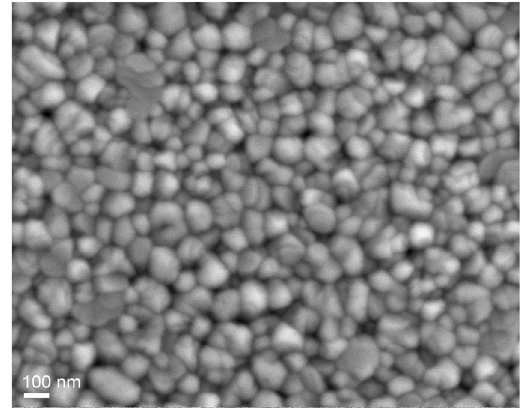
Figure 4. SEM image of 3YSZ nanoceramics. Rapid sintering at a heating rate of 250 °C/min to 1300 °C with 2 minutes of dwell time was employed. The density was 91% TD, the average grain and crystallite sizes were 106 nm and 60 nm,